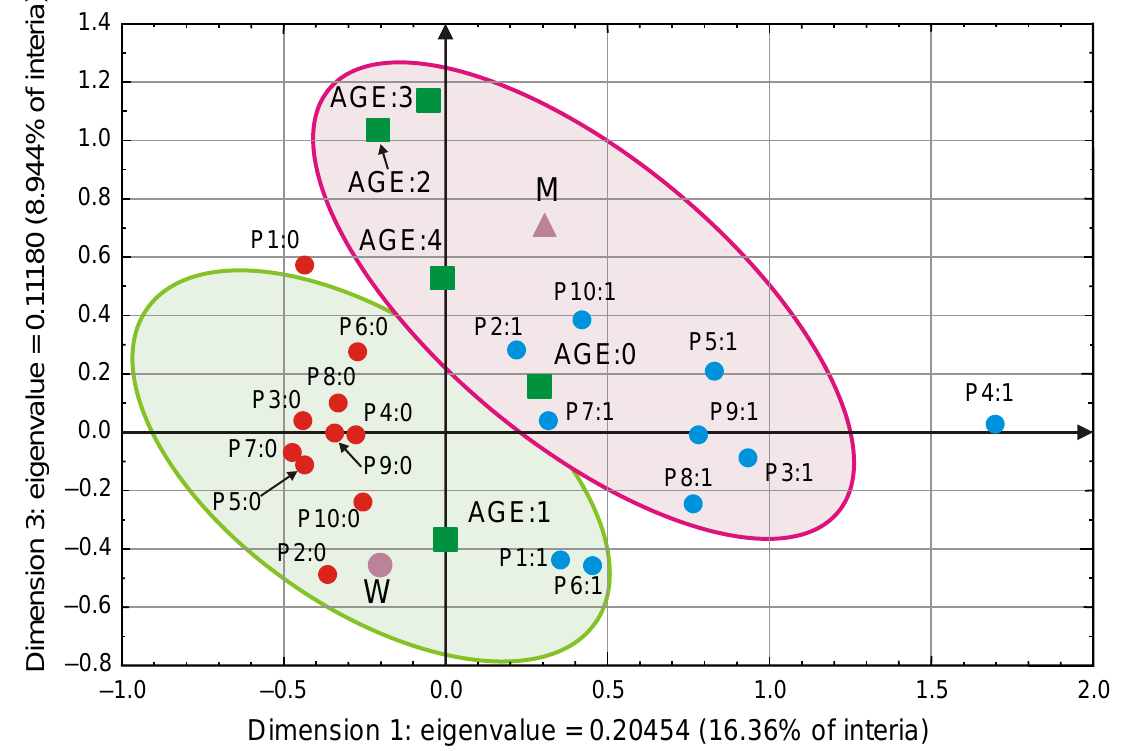
Figure 4. Three-dimensional plot of column coordinates—dimension 1  2  3. Input table (rows  columns): 27  27 Burt Table.